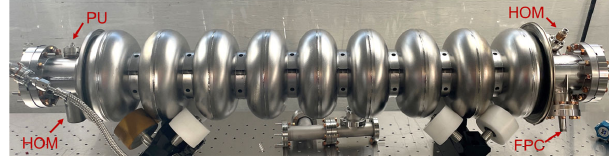
FIG. 1. Photo of TESLA shape nine-cell 1.3 GHz cavity, with highlighted ports for the higher order modes (HOM) couplers, the fundamental power coupler (FPC), and the pickup (PU) coupler.